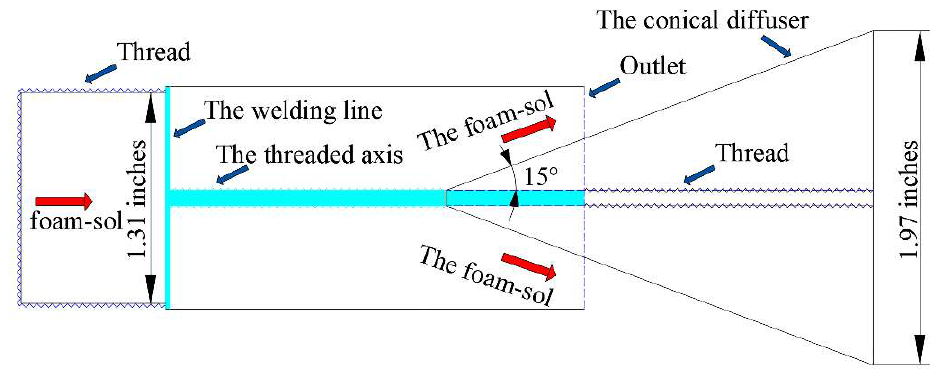
Figure 8. Structure of polyacrylamide (HPAM) molecular chain [40].